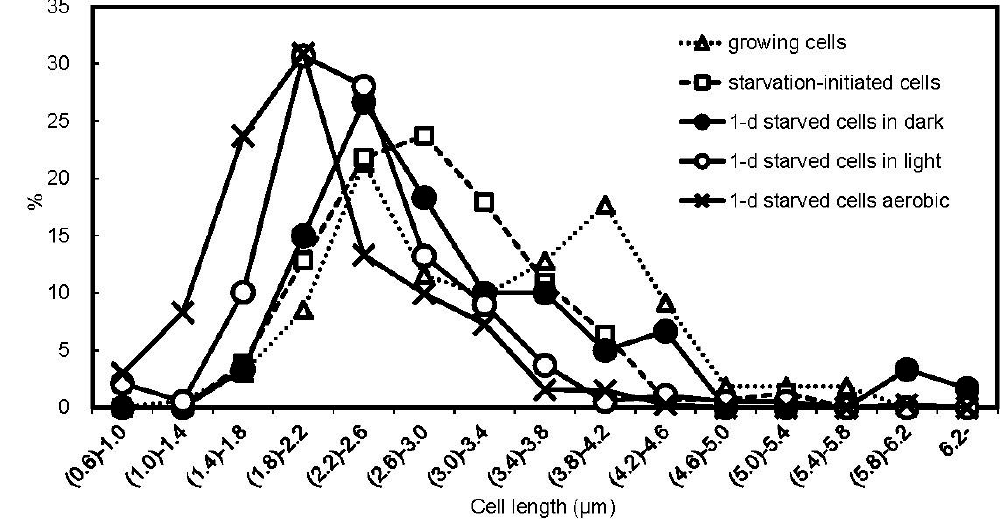
Figure 3. Frequency distribution of cell length. The length of the long axis of rod-shaped cells was measured for exponentially growing cells, starvation-initiated cells, 1-d anaerobic starved cells in the light, 1-d anaerobic starved cells in the dark, and 1-d aerobic starved cells in the dark. The frequency of the cell lengths is represented as a percentage of the total cells measured. The lengths of 150 cells were measured for each sample with three replications. The horizontal axis indicates cell length (µm), and the percentages of cells with lengths in the range in total cells measured are plotted, e.g., (0.6)–1.0 indicates a range from longer than 0.6 µm to 1.0 µm.